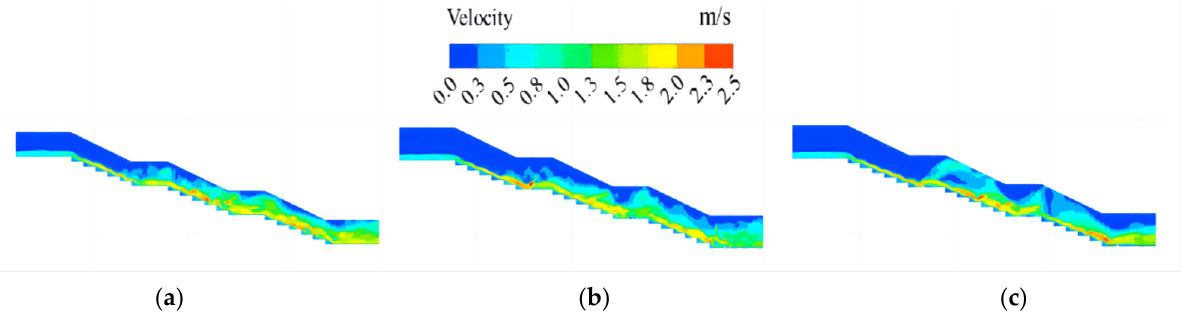
Figure 9. Flow pattern of different longitudinal sections in staggered arrangement. ( a ) y = 5 cm, and ( b ) y = 7 cm.